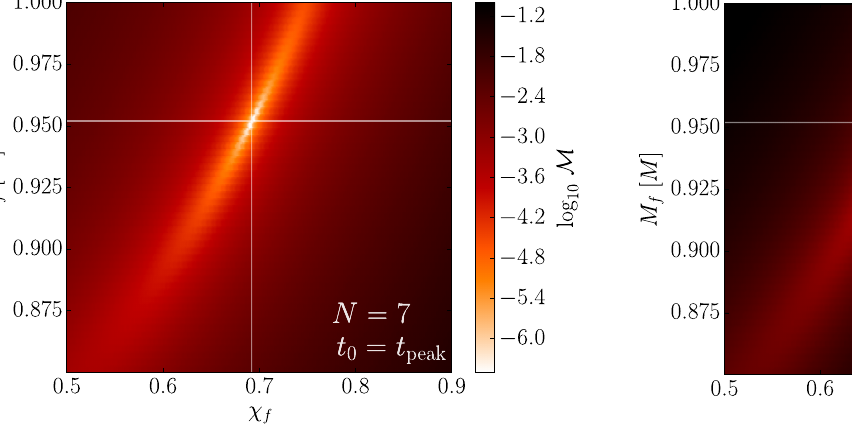
FIG. 6. Mismatches for the l ¼ m ¼ 2 mode between NR and . The Eq. (1) for a grid of M f and χ f with N ¼ 0 , the fundamental peak 47 M . Here, the fundamental mode, at a late time t 0 ¼ t peak þ mode is dominant since the overtones have decayed away by this time. Again, the white horizontal and vertical lines correspond to the remnant values from NR and now; at this late time, we find good agreement between the true values and those recovered by using only the fundamental mode as a probe for M f and χ f